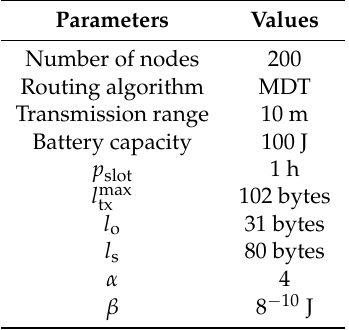
Table 1. Simulation